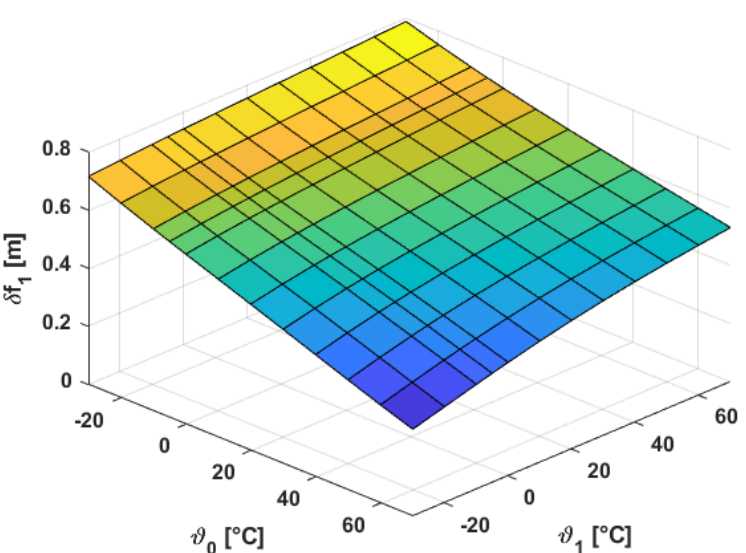
Figure 16. The dependence of sag uncertainty caused by the cumulation of errors of state equation input parameters.